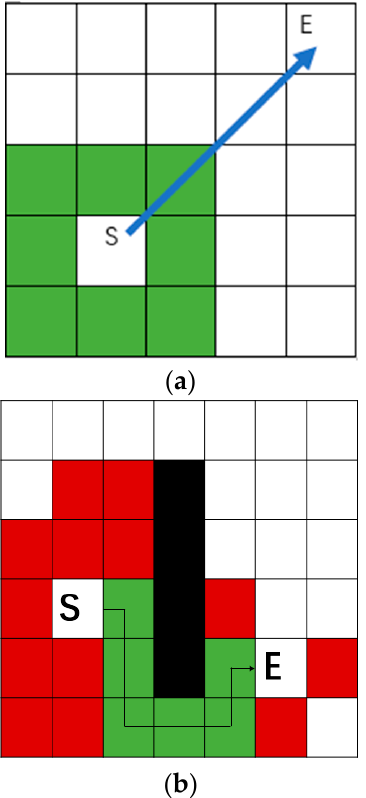
algorithm and the RRT algorithm. The simulation comparison and data analysis confirm the fast, robust and advanced nature of the optimized fusion algorithm.